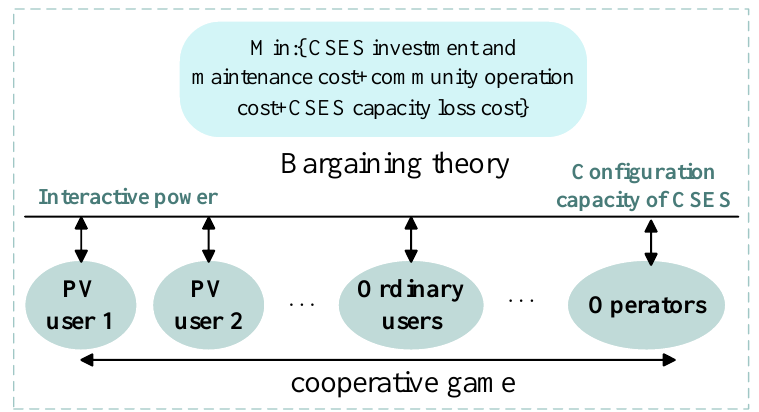
Figure 2. Cooperation game framework.